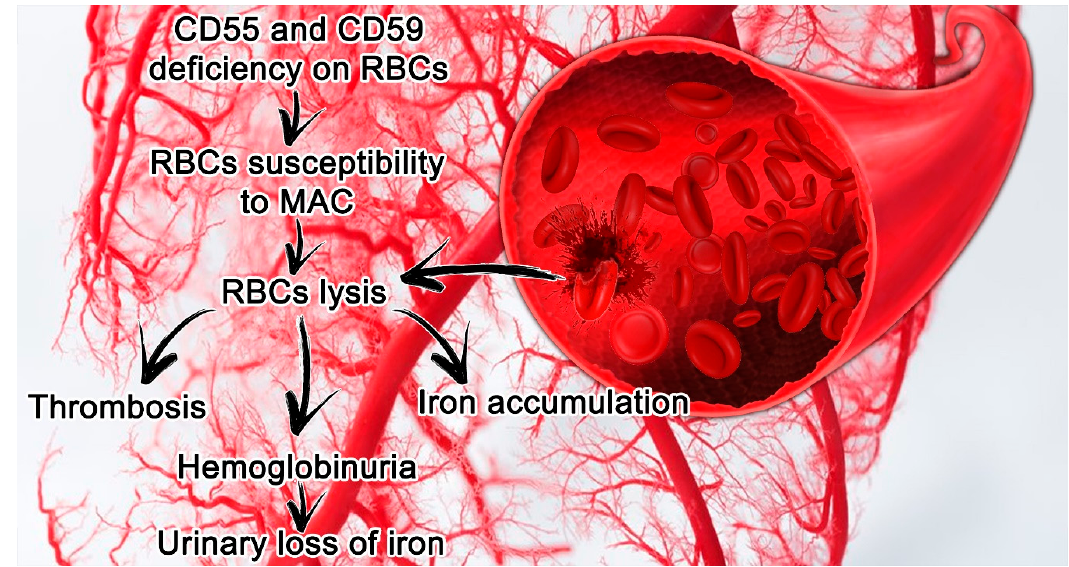
Figure 1. Paroxysmal nocturnal hemoglobinuria (PNH) features in small vessels and its consequences. Erythrocytes lacking CD55 and CD59 are more susceptible to hemolysis mediated by MAC, which leads in turn to thrombosis and the release of hemoglobin and free iron. Abbreviations: CD55, a decay accelerating factor; CD59, a membrane inhibitor of reactive lysis; RBC, red blood cells; MAC, membrane attack complex.